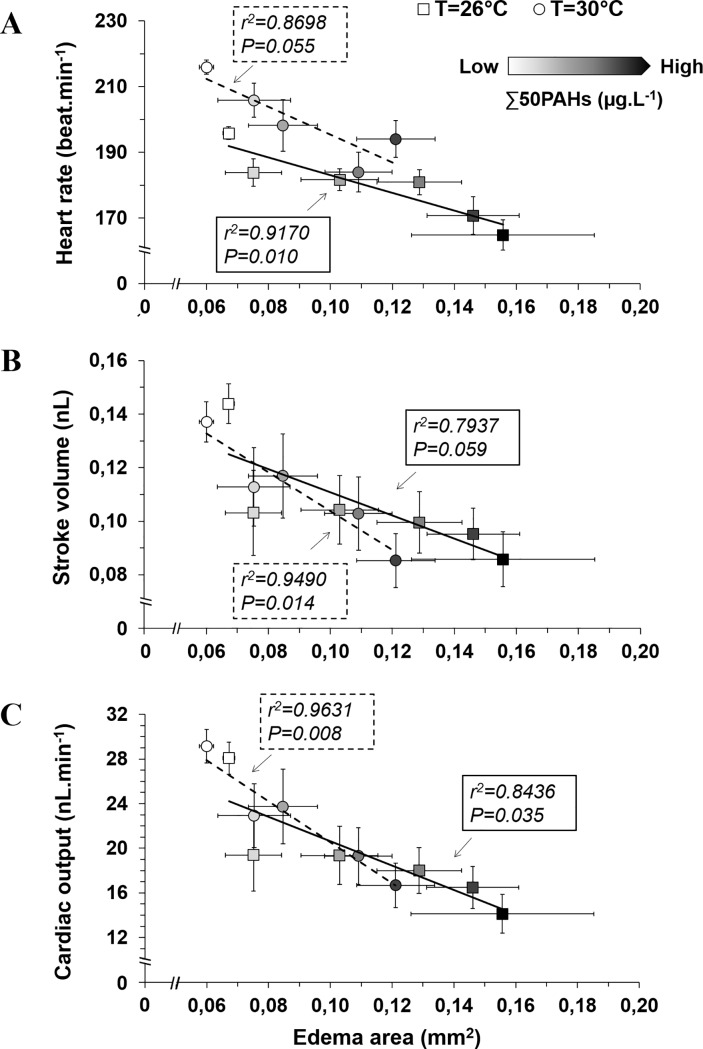
Correlation between cardiac variables and extent of edema in mahi larvae under combined oil and temperature exposures.N = 20–39 at 26°C and N = 20–56 at 30°C. Data are presented as Mean±SEM. Solid and dashed lines represent linear regressions at 26°C and 30°C, respectively.